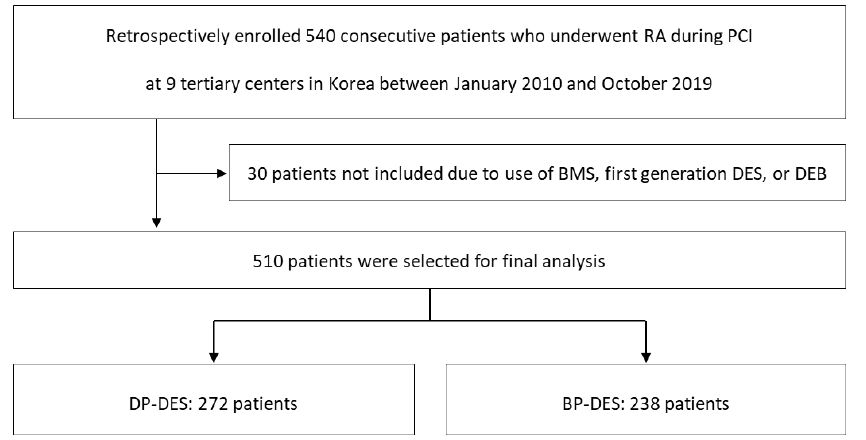
Figure 1. Study Population Flow Chart. RA, rotational atherectomy; PCI, percutaneous coronary intervention; BMS, bare metal stent; DES, drug eluting stent; DEB, drug eluting balloon; DP, durable polymer; BP; biodegradable polymer.